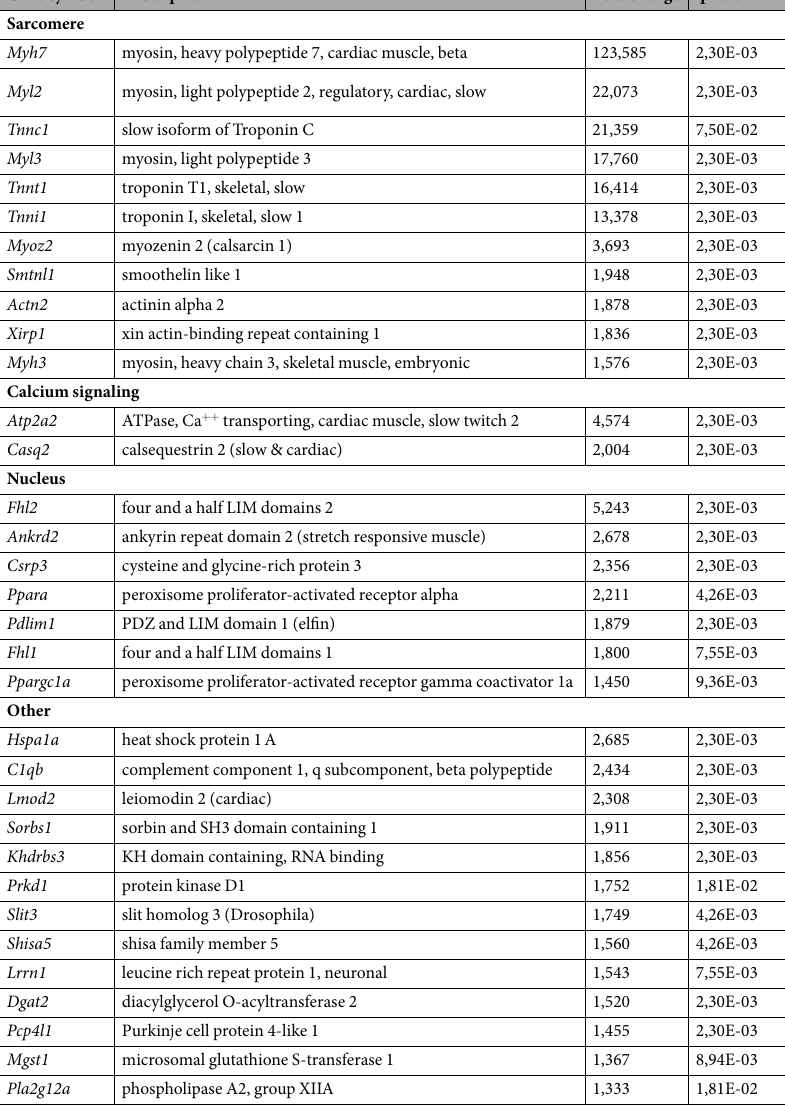
Table 2. Slow myofiber-specific genes overexpressed in cyclin D3 − / − muscle. List of genes upregulated in D3 − / − muscle, as identified in RNA-seq, overlapping those specifically expressed in slow myofibers, as determined by Chemello et al .,